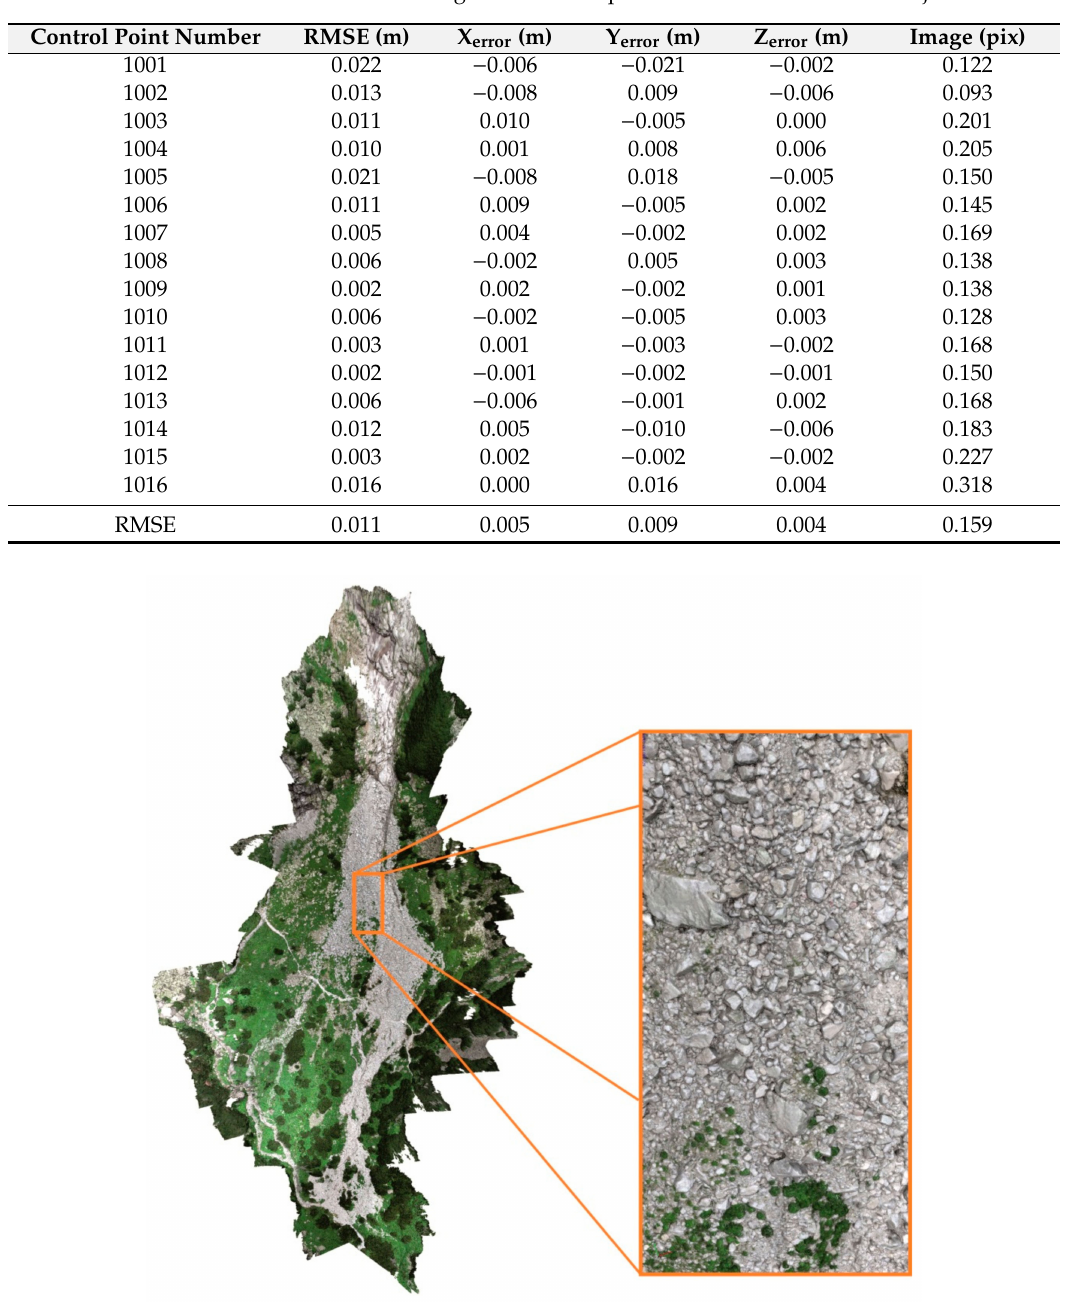
Figure 11. Data from photogrammetric image processing by SfM method—entire area and